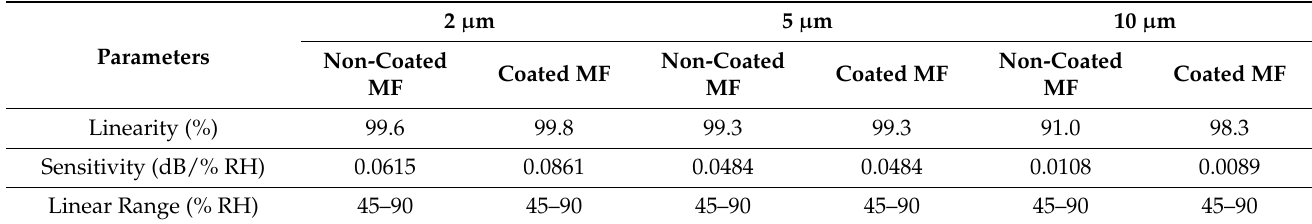
Figure 8. Transmitted power value for three different diameters of WS 2 : ( a ) coated MFs and ( b ) non-coated MFs. Power varies with the percentage of humidity. Table 1. Analysis of different diameters of MF with WS 2 performance in humidity sensing activity.